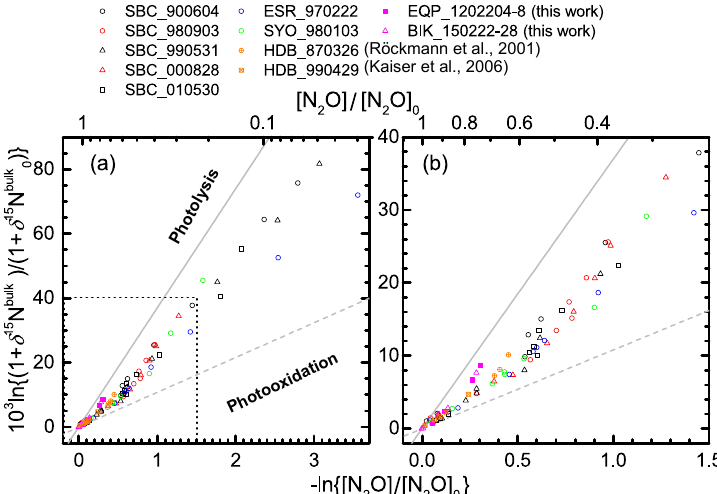
Figure 3. Correlation between mixing ratio and δ 15 N bulk of N 2 O (Rayleigh plot). The high mixing ratio range ( > ca. 120nmolmol − 1 ) in (a) is enlarged in (b) . Both parameters are normalized to their values at the time when the corresponding air mass entered the stratosphere (see Eq. 6 in the text). Grey solid and broken lines show slopes obtained respectively from laboratory broadband photolysis experiments (Kaiser et al., 2002b, 2003) and photooxidation experiments (Kaiser et al., 2002a; Toyoda et al.,